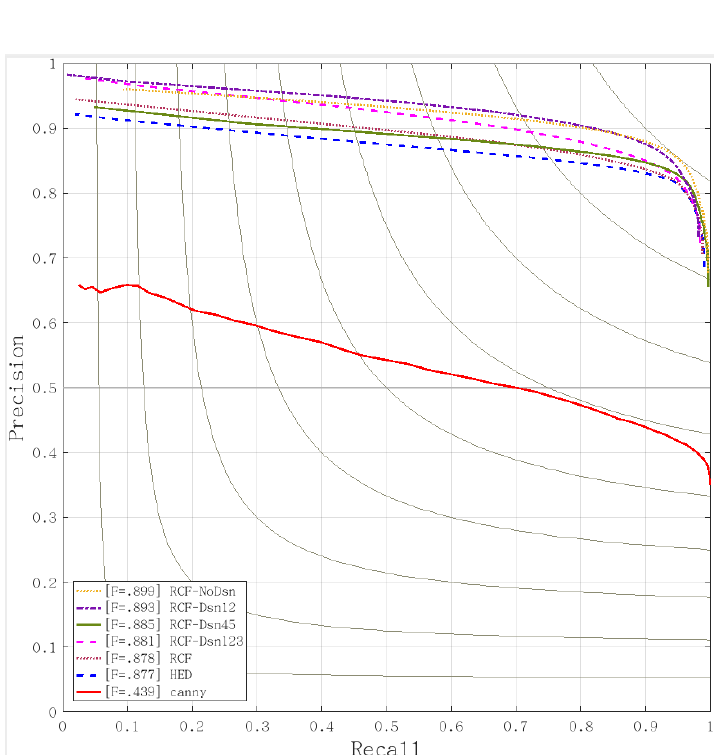
Figure 11. P-R curve of each edge detection